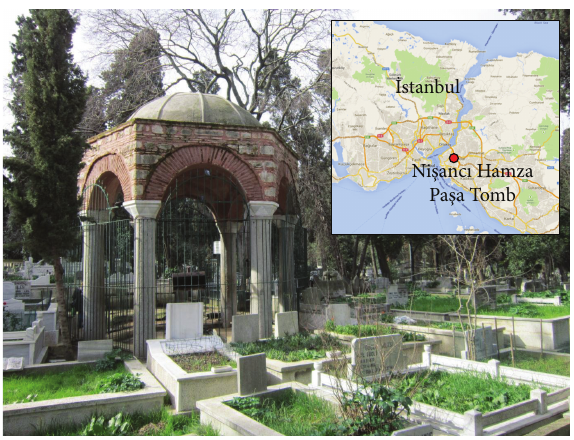
Figure 1: Nis¸ancı Hamza Pas¸a tomb in Karacaahmet